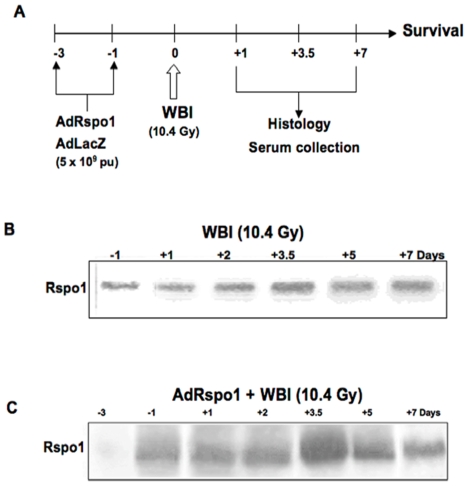
Time course evaluation of serum Rspo1 expression.(A) Treatment schema: AdRspo1 or AdLacZ (5×109 pu) was injected intravenously 3 and 1 day before WBI (10.4 Gy) in C57Bl/6 mice. Animals were followed for survival and histological endpoints. (B) Immunoblots of murine serum demonstrating time course evaluation of serum Rspo1 expression after WBI. (C) Representative immunoblot of serum Rspo1 levels in C57Bl/6 mice, following treatment with AdRspo1 + WBI.